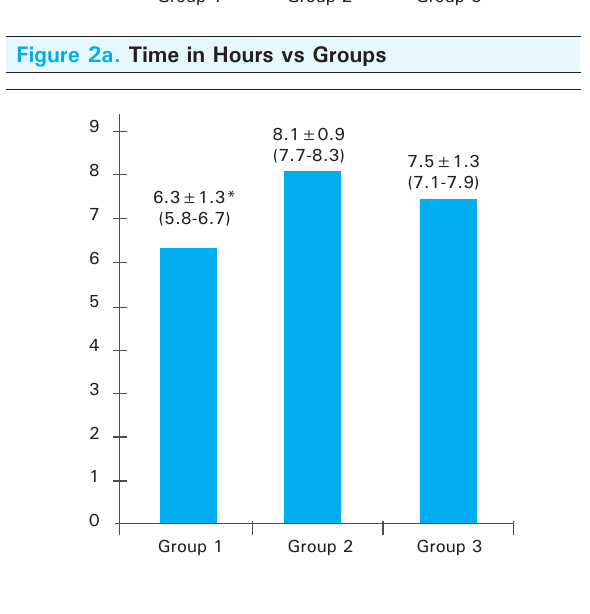
Figure 2a. time in hours vs groups